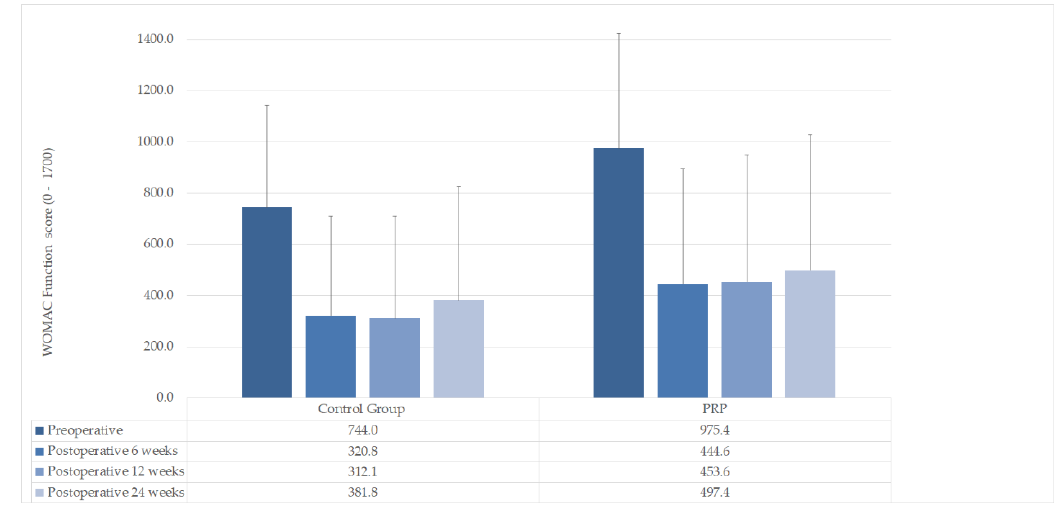
ff ness WOMAC scores.